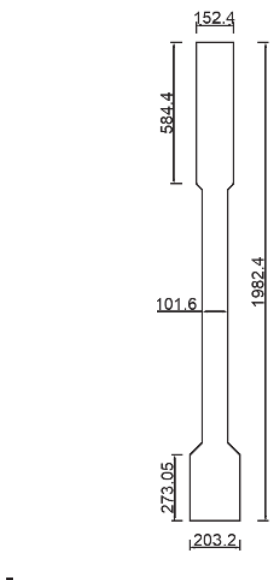
Figure 11 Beam cross section (dimensions in mm) Source: Adapted from Consolazio, Hamilton and Beery [3]